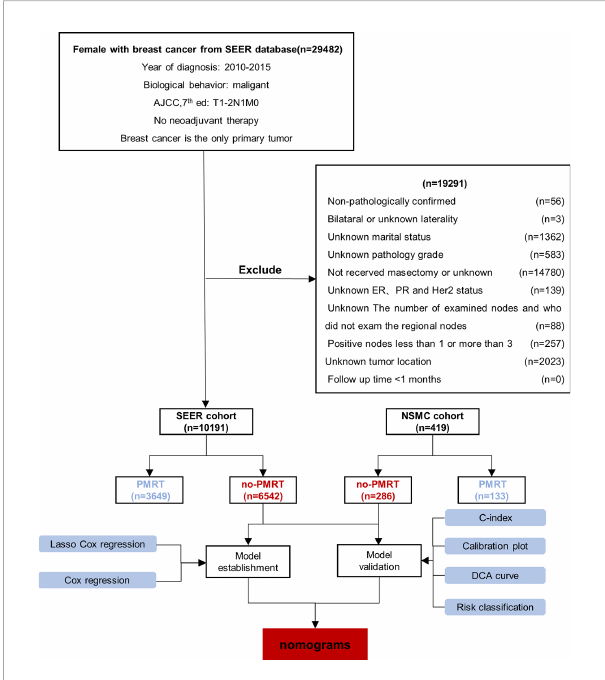
FIGURE 1 Patients ’ enrollment and exclusion fl ow chart. The SEER cohort comprised 10191 patients, which were further separated into the no-PMRT (training set, n=6542) and PMRT group (n=3649). The NSMC cohort consisted of 419 patients, who were further divided into the no-PMRT (n=286) and PMRT group (n=133). PMRT, postmastectomy